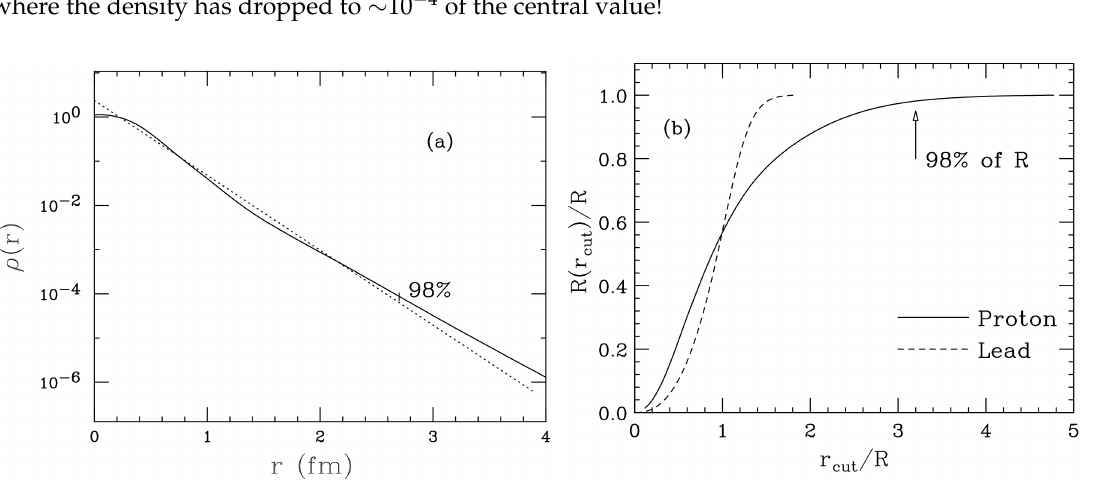
Figure 2. ( a ) Density (dotted = exponential, solid = realistic) as a function of r . ( b ) R ( r cut ) / R as a function of r cut / R . The result for a heavy nucleus is shown for